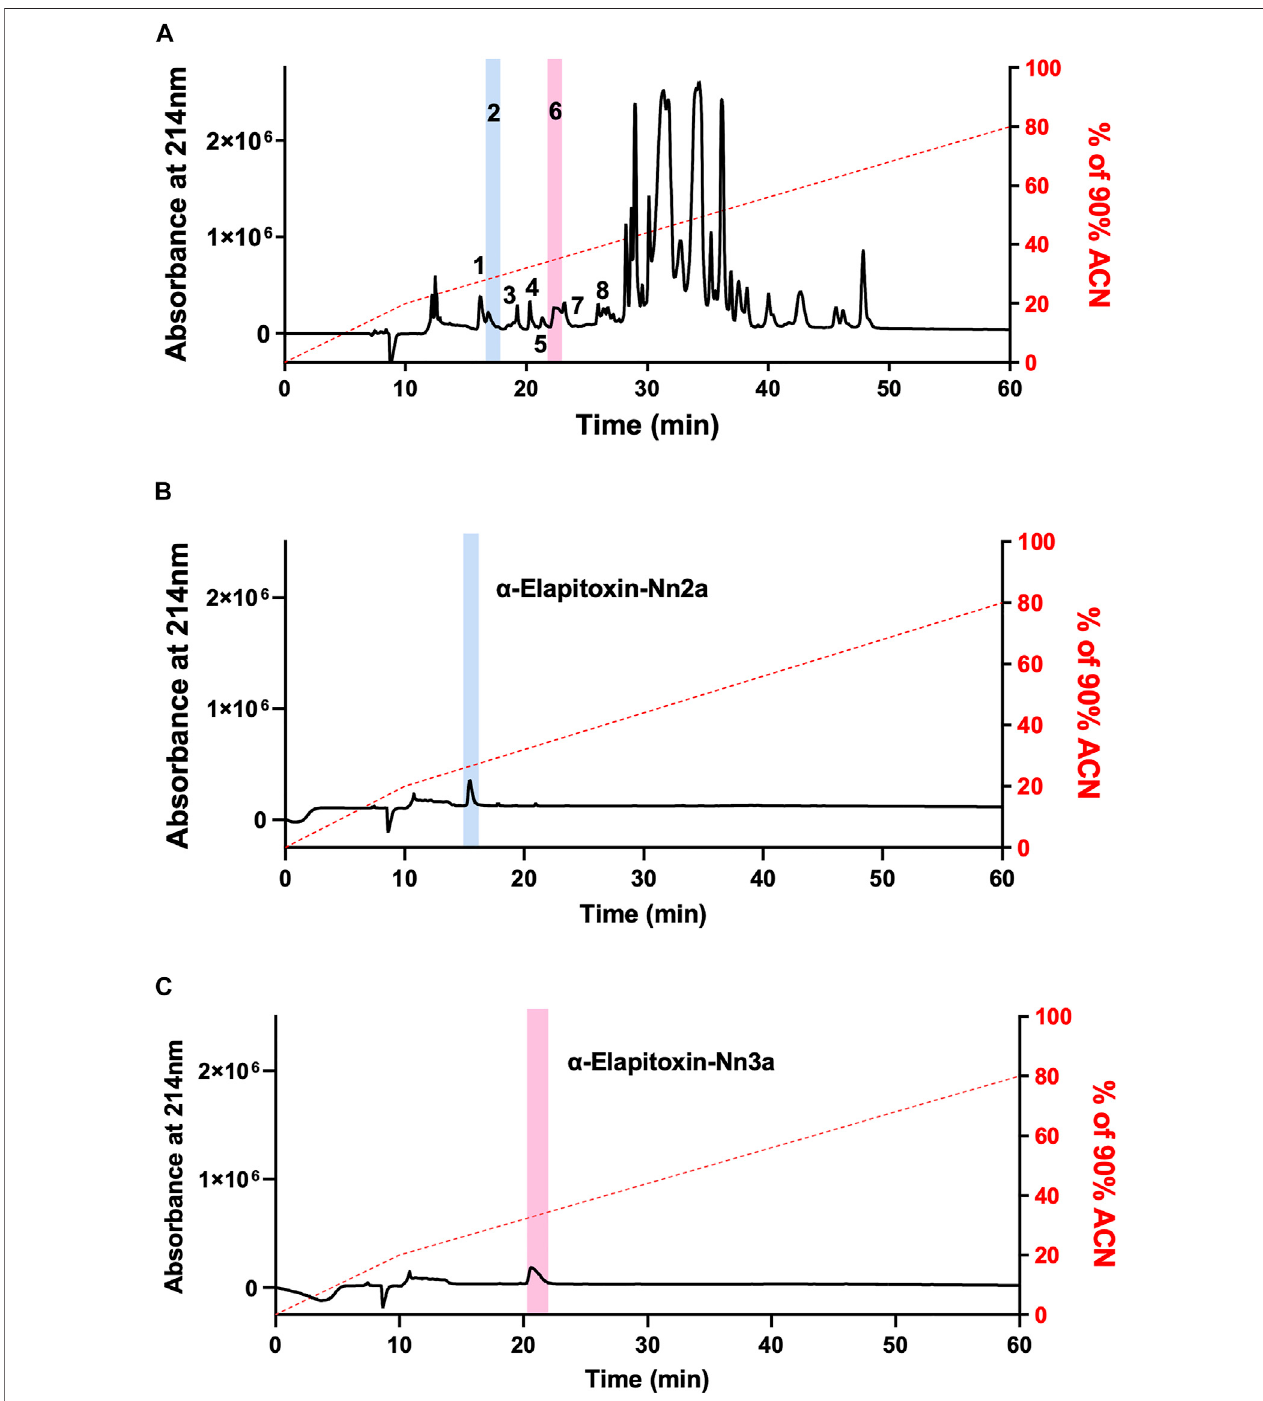
FIGURE 2 | Chromatograms of N. naja venom showing the fractionation steps to purify α -Elapitoxin-Nn2a and α -Elapitoxin-Nn3a. (A) N. naja venom, (B) α - Elapitoxin-Nn2a and (C) α -Elapitoxin-Nn3a by reverse-phase HPLC on a Jupiter C18 semi-preparative column.